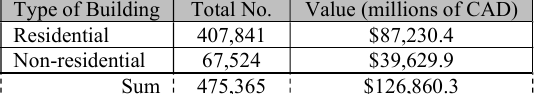
Table 1 . Total number and value of issued building permits in 2021 in Canada extracted from Statistics Canada 1 The value of permits, including materials, labour, profit, and overhead, proves how costly it can be to revoke a mistakenly issued permit during/after